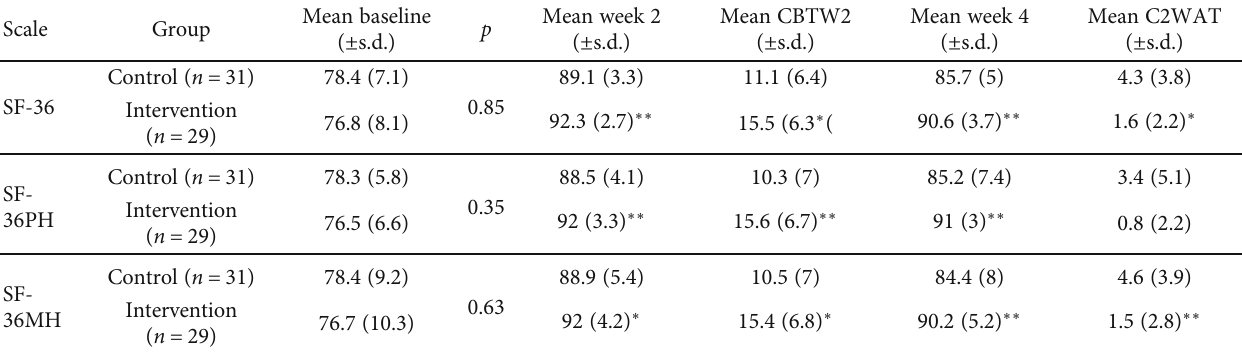
Table 3: The mean score of SF-36, SF-36PH, and SF-36MH. Intention-to-treat population.